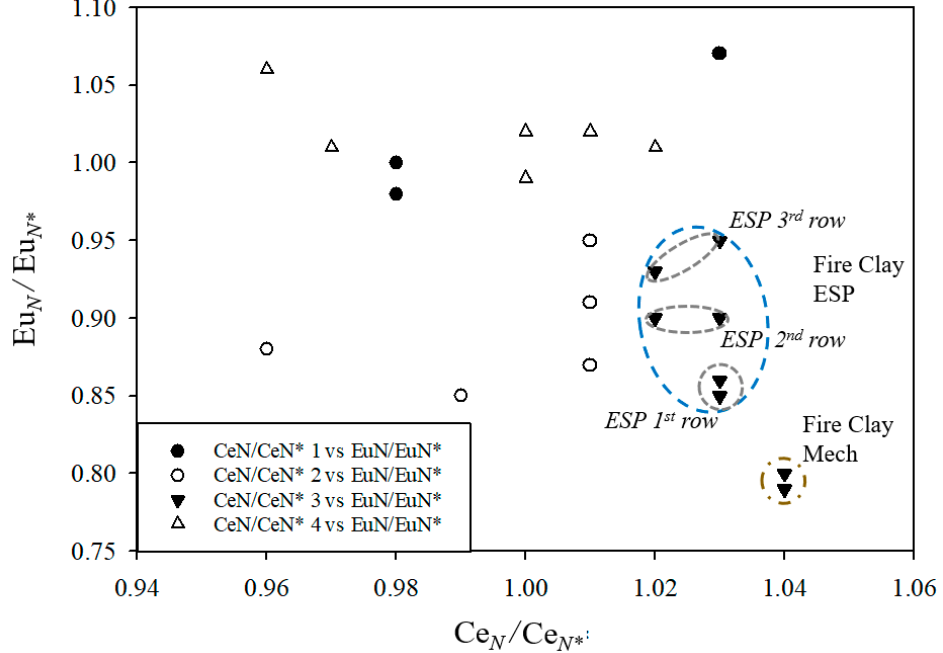
Figure 5. Eu N /Eu N * vs. Ce N /Ce N * for all of the samples.